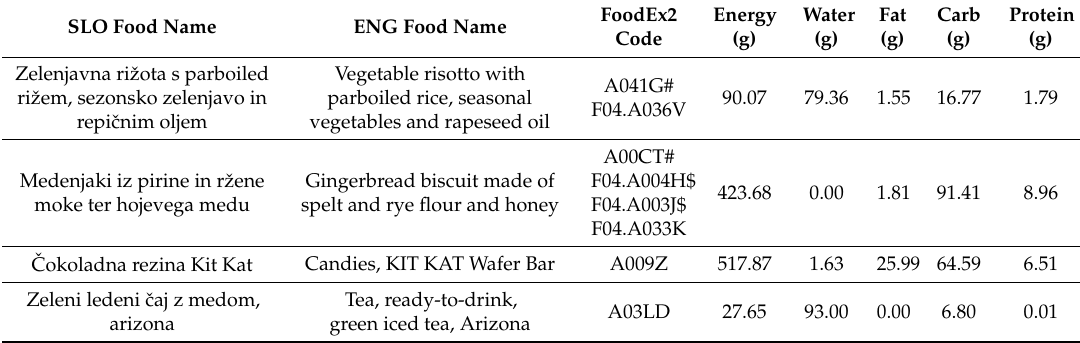
Table 1. Subset from the dataset used in the experiments (SLO—Slovenian, ENG—English).